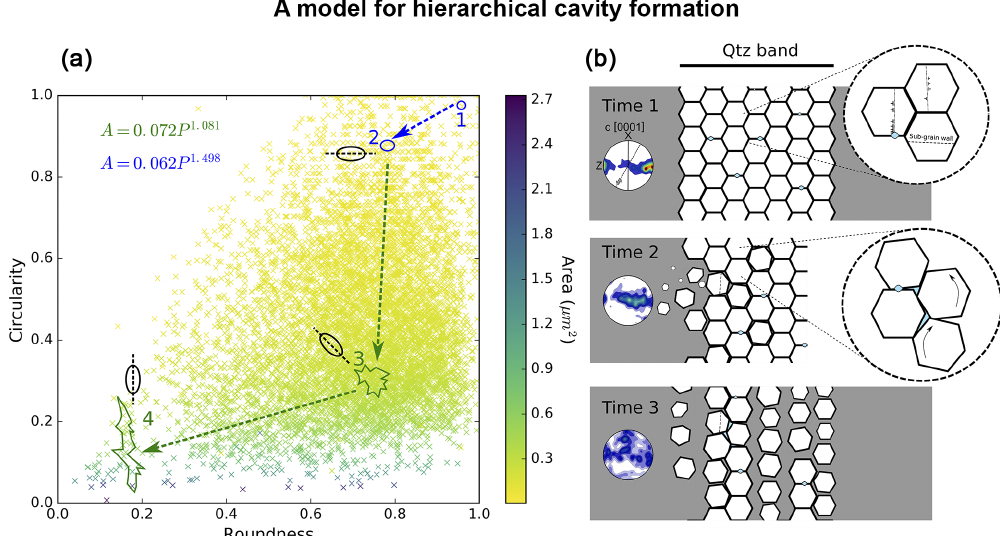
Figure 10. A model for synkinematic creep cavity formation by two different mechanisms. Panel (a) graphically represents the inferred trajectory of a creep cavity’s life cycle. Initially creep cavities grow from circular (1) to elliptical cavities (2). These cavities generally have long axes aligned in the Z direction (when viewed in the XZ plane). As cavities become larger they develop more complex shapes and rotate (3), ultimately elongating and becoming more aligned with the shear plane (4). Panel (b) schematically integrates our observations of cavity evolution with the evolution of the microstructure and the associated micro-mechanisms. First cavities form in quartz domains deforming by GSI creep through the Zener–Stroh mechanism ( b , time 1). As the grain-boundary strength is weakened by the ingress of fluids into cavities, VGBS is promoted. This increase in the contribution of VGBS drives the production of new creep cavities of a more complex shape ( b , time 2). It is the production of creep cavities that initiates the increased contribution of VGBS and ultimately prompts a switch to a GSS creep. See text for